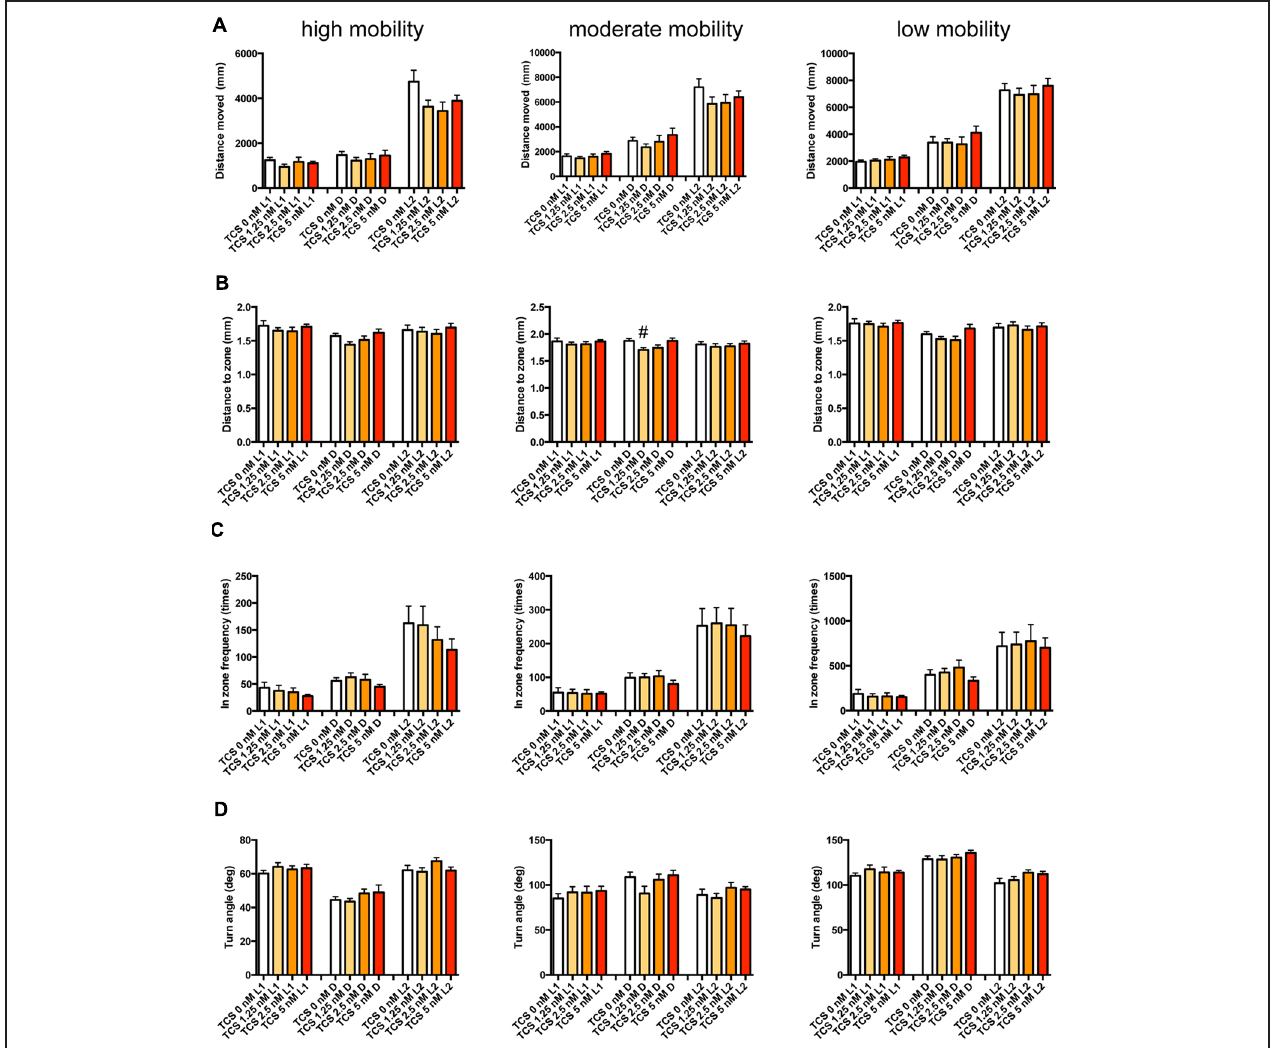
FIGURE 9 | Behavioral profiling of zebrafish treated with TCS-1102. The behavior of zebrafish treated with TCS-1102 from 9 to 10 dpf was classified into three groups based on their mobility. Distance moved (A) , distance to zone (B) , in zone frequency (C) , and turn angle (D) at L1, D, and L2 periods are shown for each mobility classification. The data are represented as means with the standard error of mean. # p < 0.05 vs. 0 μ